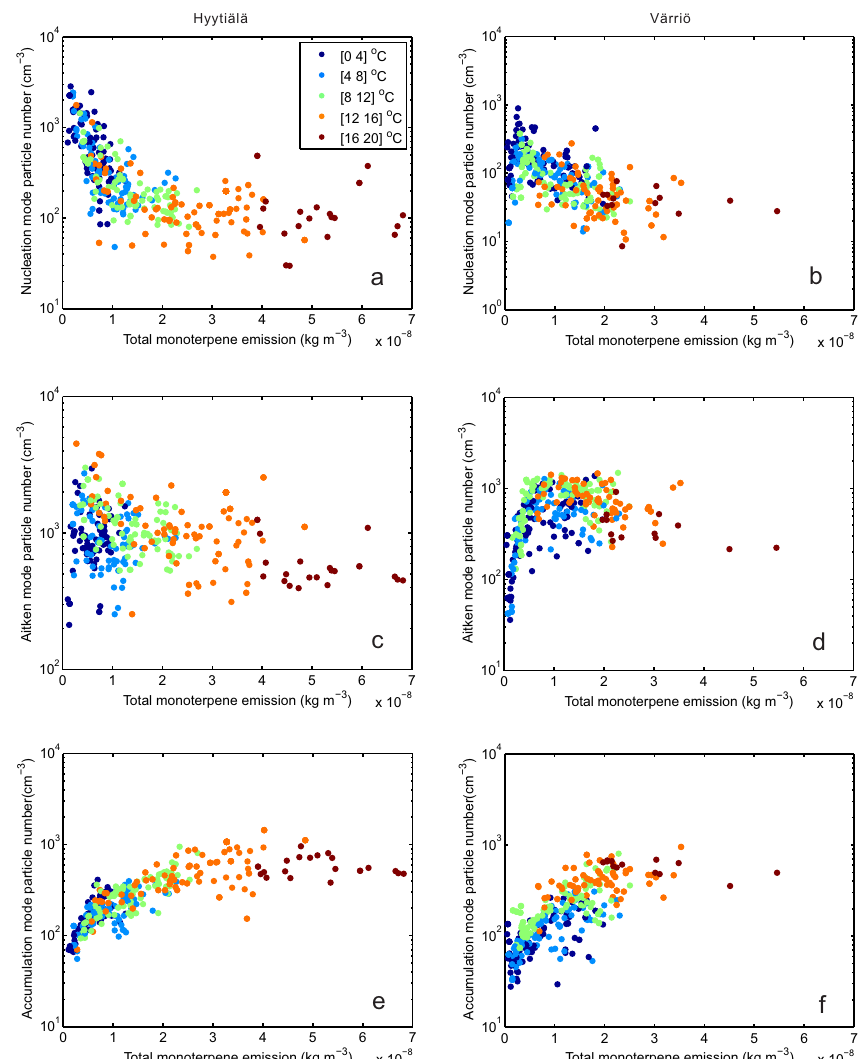
Figure 6. Nucleation mode particle number concentrations vs. total monoterpene emissions among the five temperature bins (a) at the SMEAR II station, and (b) at the SMEAR I station. Aitken mode particle number concentrations vs. total monoterpene emissions (c) at the SMEAR II station, and (d) at the SMEAR I station. Accumulation mode particle number concentrations vs. total monoterpene emissions (e) at the SMEAR II station, and (f) at the SMEAR I station. The marker colours of legends represent the same binned temperatures in all